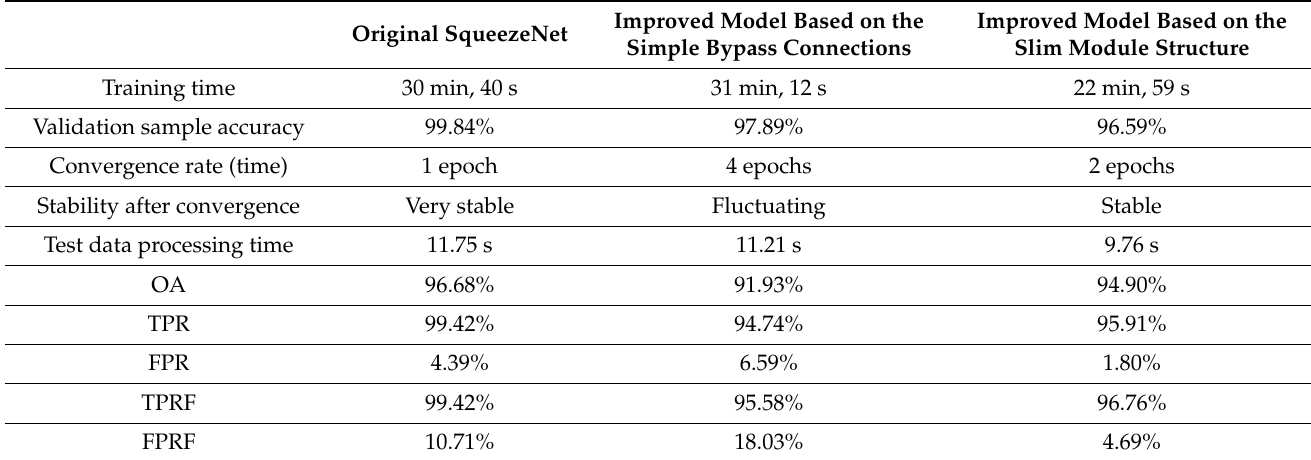
Table 5. Comparison of effects before and after